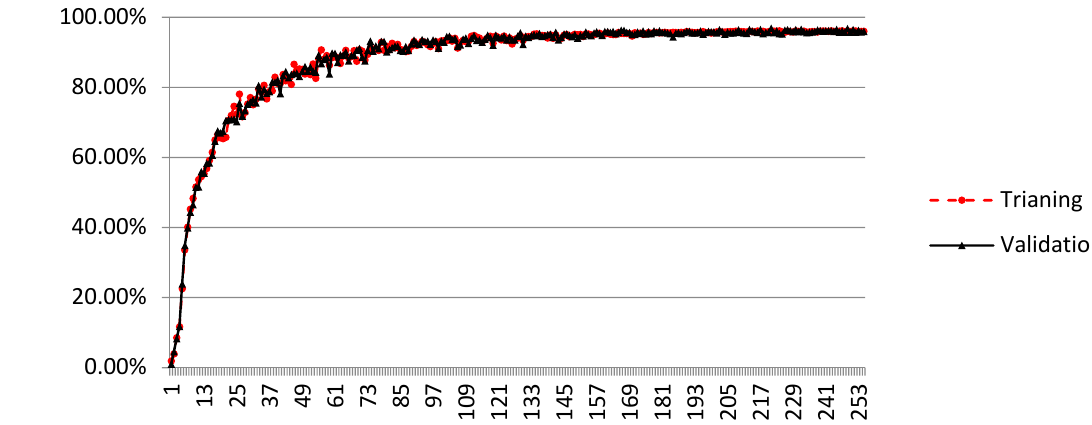
Figure 13. Training process of dataset C. Table 7. Detection results of dataset C.